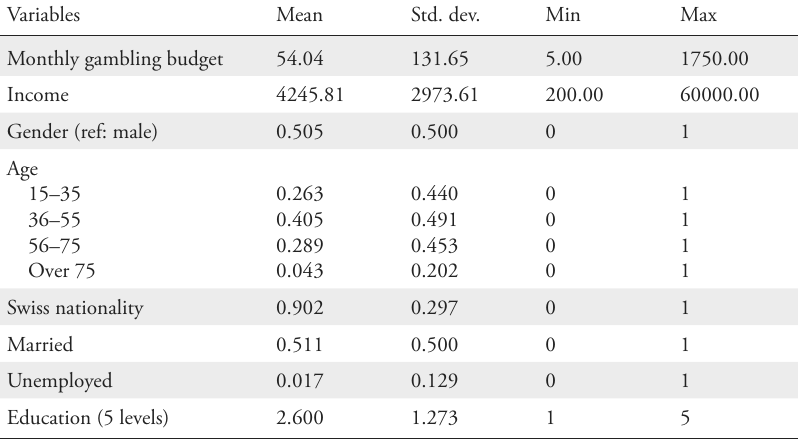
Table 2: Summary Statistics of the Regression Variables